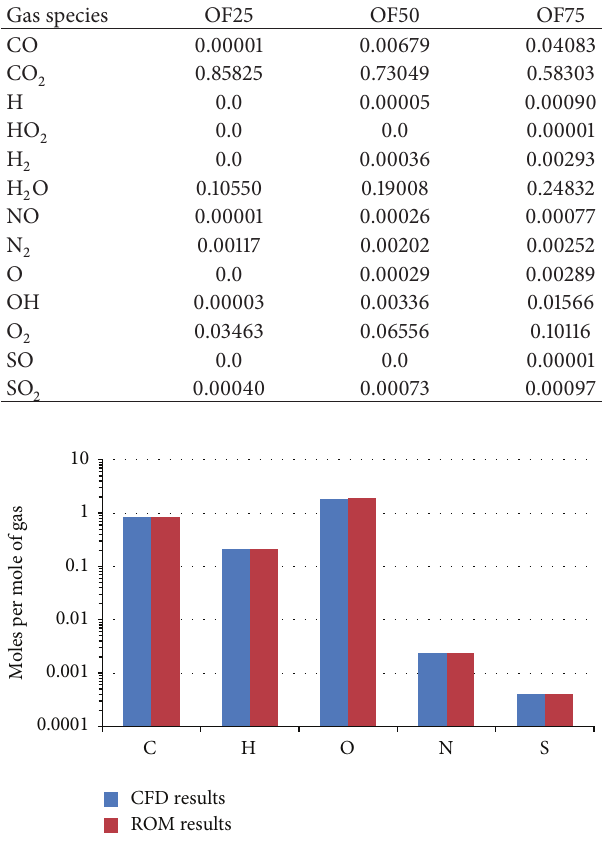
Figure 3: Elemental Balance for OF25.